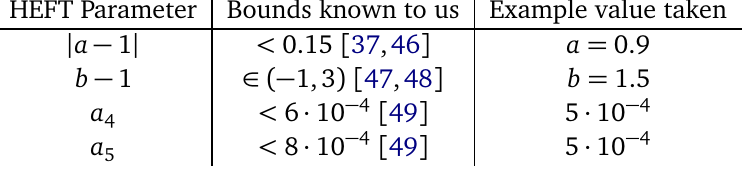
Table 1: Bounds on the parameters of the HEFT Lagrangian and the allowed example values that we have used to estimate the uncertainty in Eq. (39). We write down a sensible value from considering the 95% confidence bounds, with no attempt at combining different experiments or theoretical analysis. Additionally, v = 246 GeV as is well known from the electroweak theory. HEFT Parameter Bounds known to us Example value taken | a − 1 | < 0.15 [ 37,46